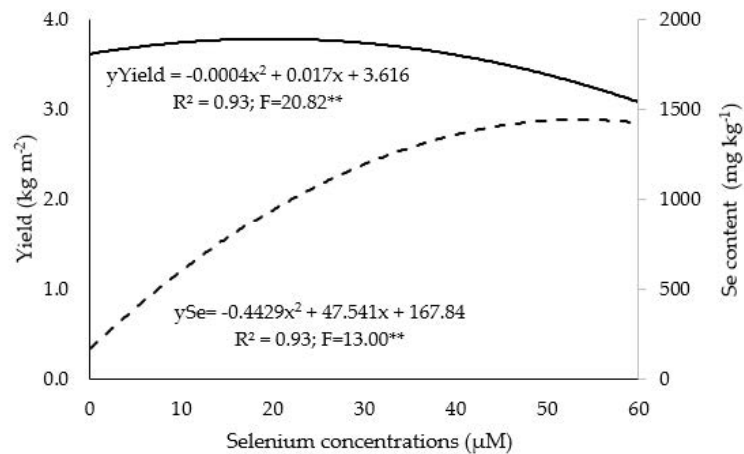
Figure 2. Rocket productivity and leaf selenium content in response to selenium concentrations in the nutrient solution. ** Significant at p ≤ 0.01.